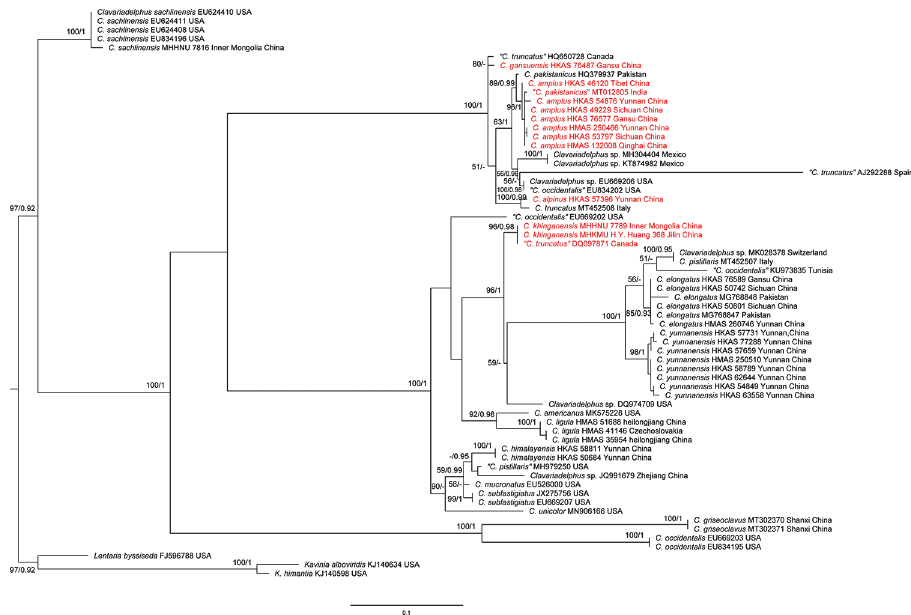
Figure 1. Phylogenetic tree of Clavariadelphus based on ITS sequence data. RAxML BP values (≥ 50%) are shown above branches, Bayesian posterior probabilities (≥ 0.90) are shown above branches; new taxa are marked in